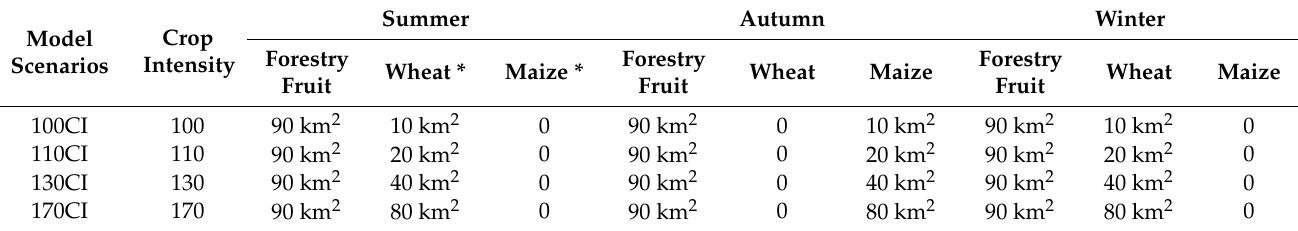
Table 3. Crop area under different model